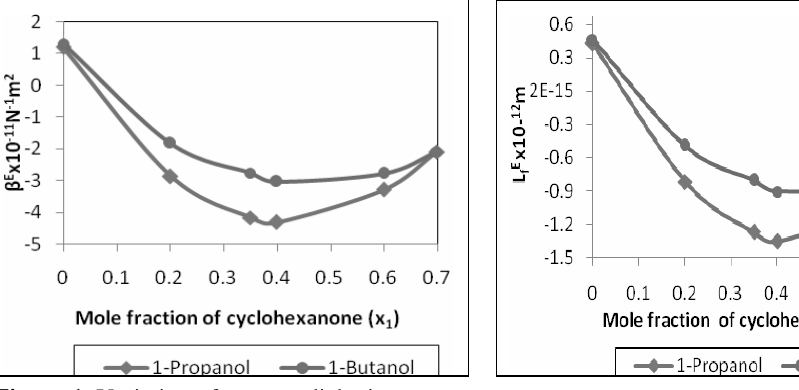
Figure 2. Variation of excess free length versus mole fraction of cyclohexanone (X